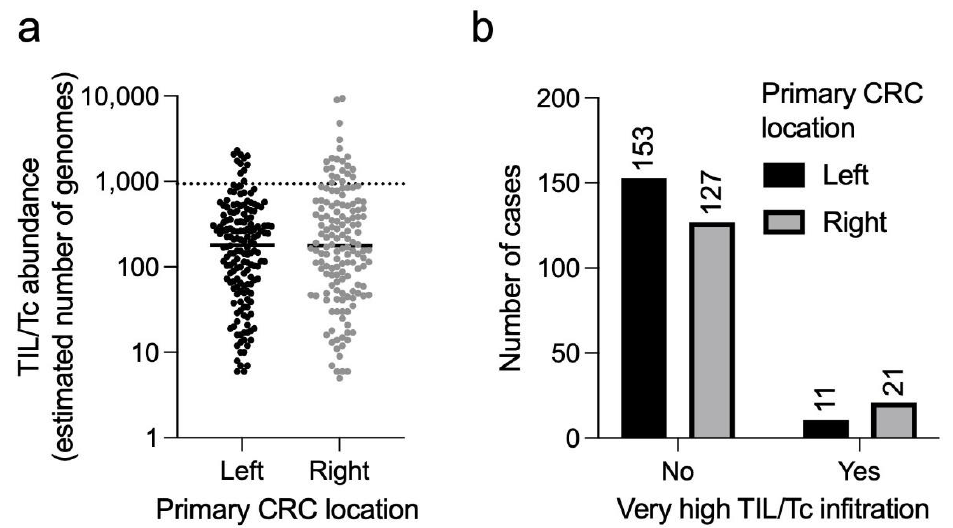
Figure 2. TIL/Tc infiltration according to CRC sidedness. ( a ) Estimated number of T cell genomes in the sample, indicative of TIL/Tc abundance, according to the cancer site. The dotted horizontal line represents the threshold for very high TIL/Tc abundance (90th percentile). ( b ) The same cases are grouped according to anatomical location and TIL/Tc abundance (“low or high” = below the threshold indicated in panel ( a ); “very high” = above the same threshold. Fisher’s exact test p = 0.039). Horizontal bars in ( a ) represent median values.